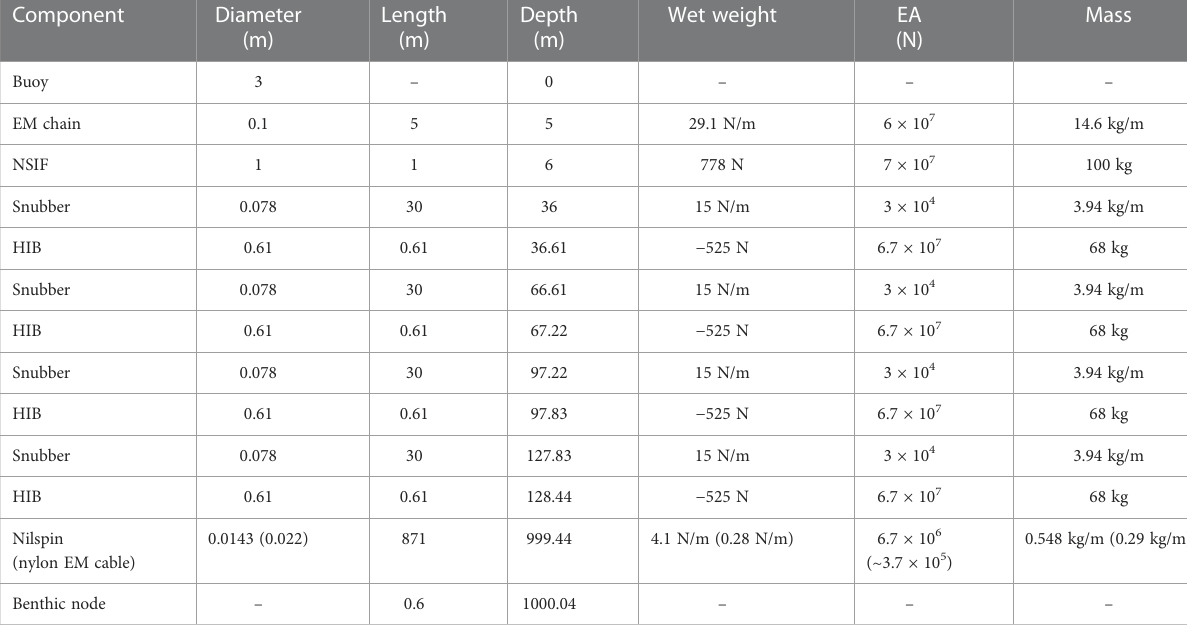
TABLE 5 Components of the mooring system in order with the snubber near the buoy.